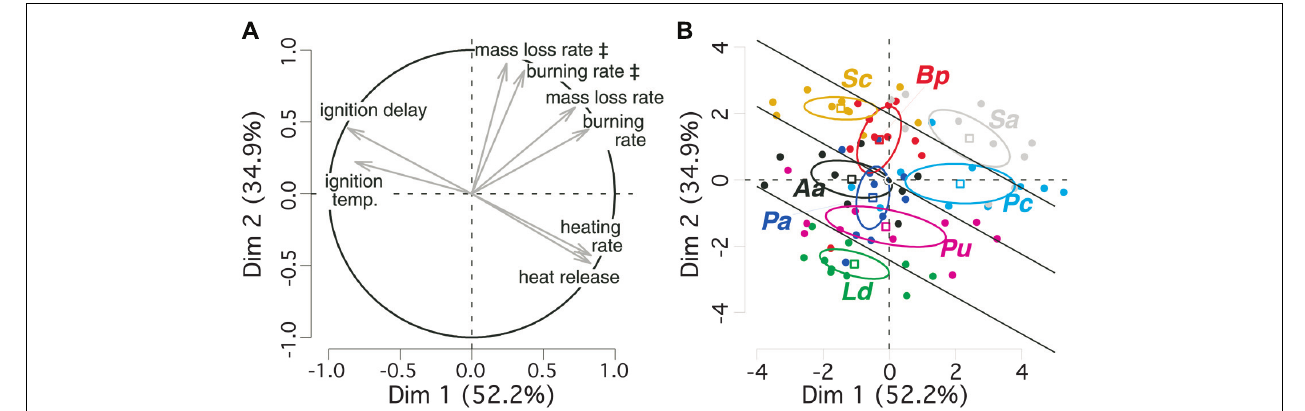
FIGURE 2 | Principal component analysis (PCA) of bark flammability for eight subalpine tree species. 95% confidence intervals for average coordinates of species are depicted by ellipses (means ± SE). (A) The circle indicates correlations and contributions of flammability parameters on the two first factorial axes; (B) individual dispersion is depicted on the two factorial axes. The symbol ‡ indicates variables that are computed over the time period of bark flaming combustion only (90 s since ignition). Species